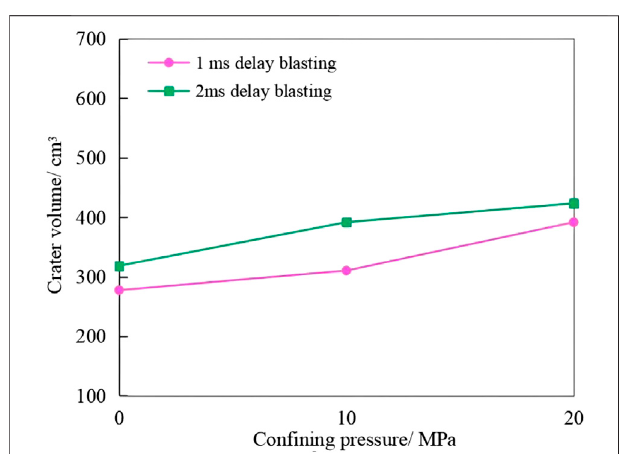
FIGURE 13 | Crater volume of delayed initiation blasting under con fi ning